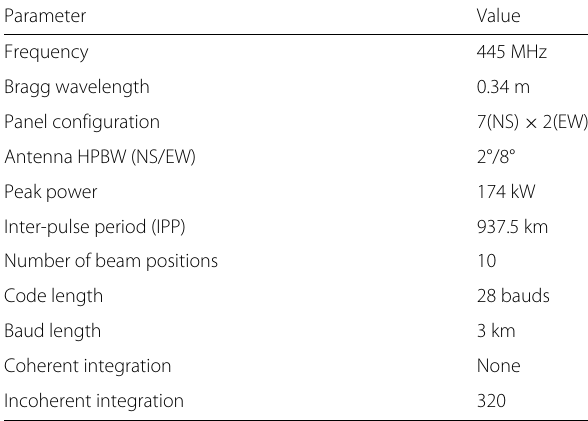
Table 1 AMISR-14 experiment parameters